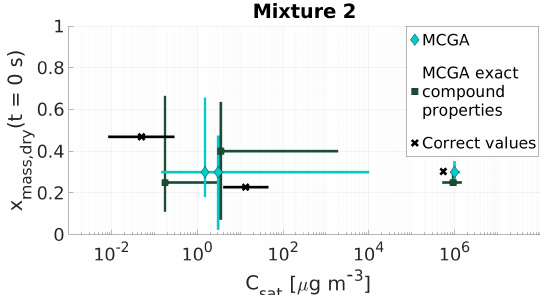
Figure 8. Parameter estimates for particles generated from mix- ture 2. Dry particle mass fraction at the start of the evaporation of three compounds and their saturation concentrations were op- timized to match the evaporation data. Cyan diamonds show the MCGA estimates calculated by assuming equal molar mass and particle-phase density for all compounds, and teal squares show the MCGA estimates calculated by setting the molar mass and particle- phase density to their literature values. Black crosses show the cor- rect values. The whiskers of the estimates show the 10th and 90th percentiles of the estimated variable distributions and the whiskers of the correct values show the range of literature values (see Table 4 for